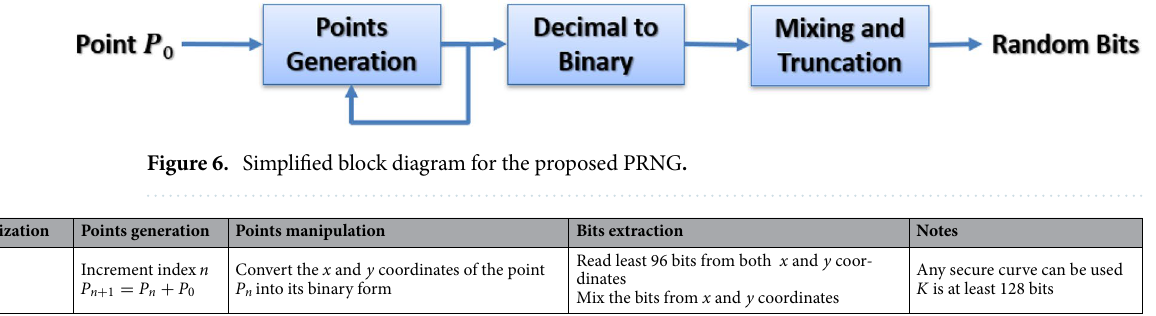
Table 4. Mapping of the proposed PRNG into the proposed